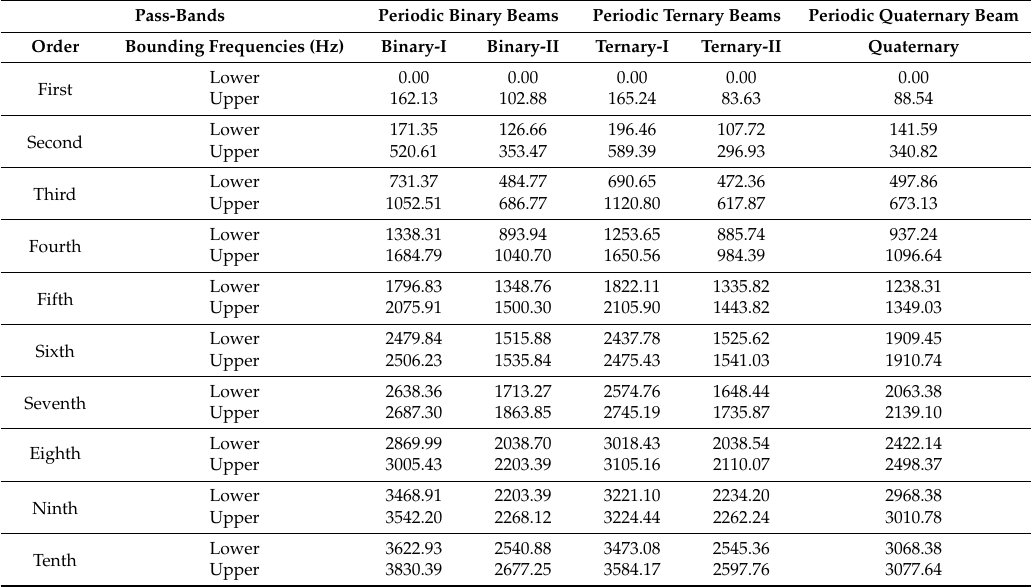
Table 3. The bounding frequencies of the first 10 pass-bands of bending waves in the five exemplified bi-coupled periodic multi-component